Question: Sum up the contents of this chart in one sentence.
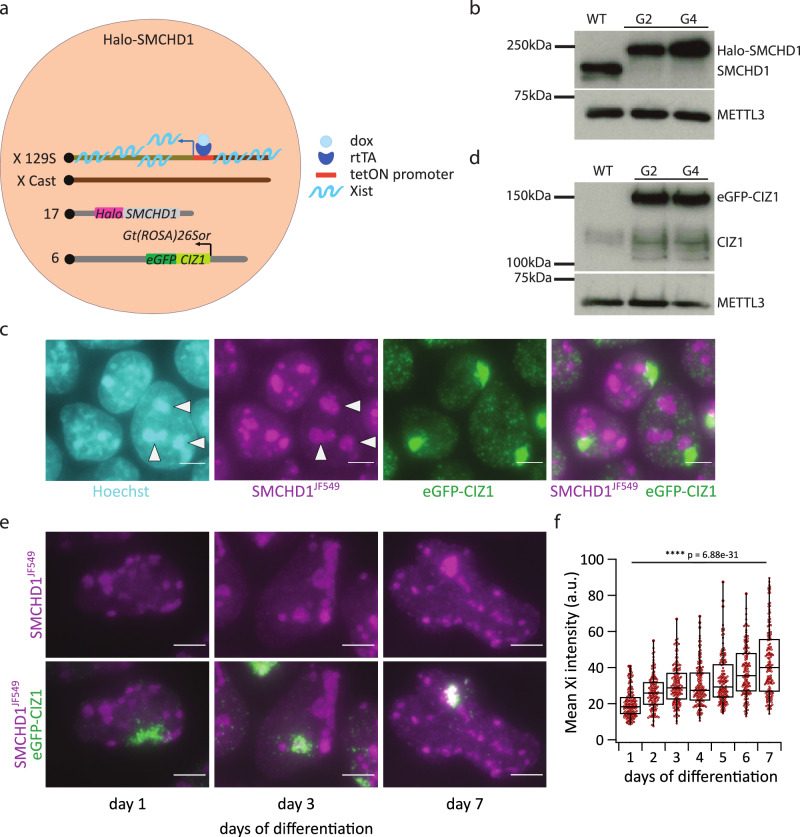
Answer: A model system to analyse dynamic interactions of SMCHD1 with chromatin. a Schematic of the Halo-SMCHD1 XX mESC line generated in the iXist-ChrX mESC line. b Western Blot showing the level of expression of Halo-SMCHD1 in two independent clones. Clone G2 was used for further experiments. METTL3 loading control c Representative live-cell images of Halo-SMCHD1 mESC line, taken after 24 h doxycycline addition. Arrowheads indicate selected PCH domains. Images are maximum-intensity projections, scale bar - 5 µm. (three independent replicates) d Western blot showing the expression of eGFP-tagged CIZ1 in two independent clones. METTL3 loading control e Representative live-cell images showing gradual accumulation of SMCHD1 over the Xi domain marked by eGFP-CIZ1 during mESC differentiation. Images are maximum-intensity projections, scale bar - 5 µm. f Quantification of SMCHD1 signal underlying the CIZ1 domain at each day during a 7-day live-cell imaging differentiation timecourse. Each dot represents a single cell, n = 136-159. Boxplots: centre lines indicate the median, box limits indicate the first and third quartiles, and whiskers extend to min/max data points. Statistical analysis was performed by a two-sided unpaired t-test. Source data are provided as a Source Data file.